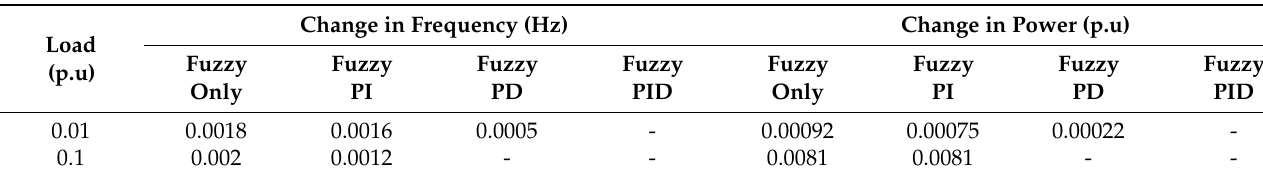
Figure 11. Dynamic response comparison of different control configurations of IHPS frequency change with step input of 1% increase in load.